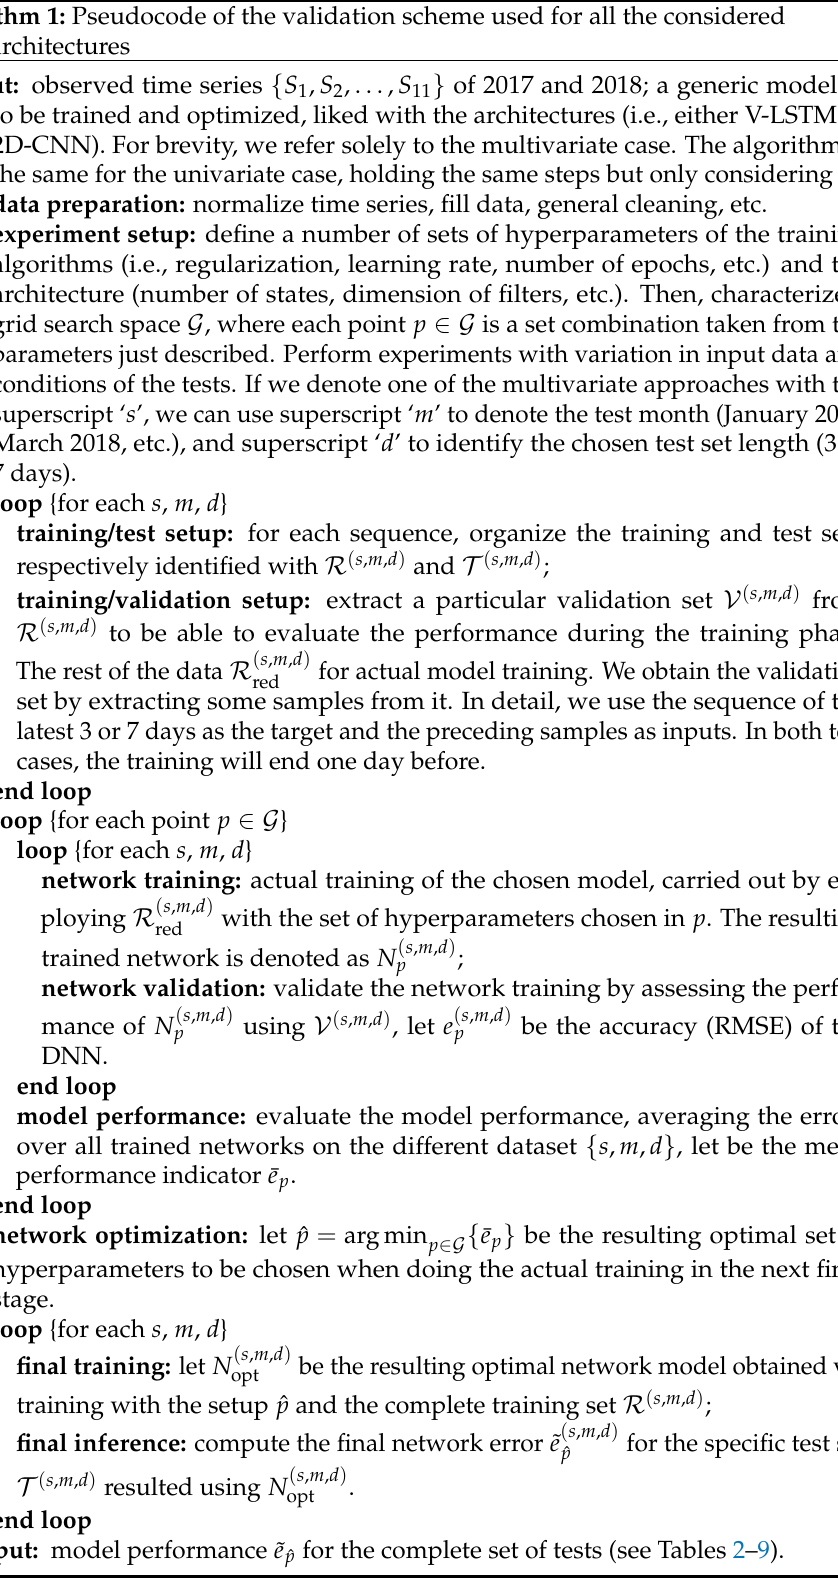
Algorithm 1: Pseudocode of the validation scheme used for all the considered DNN